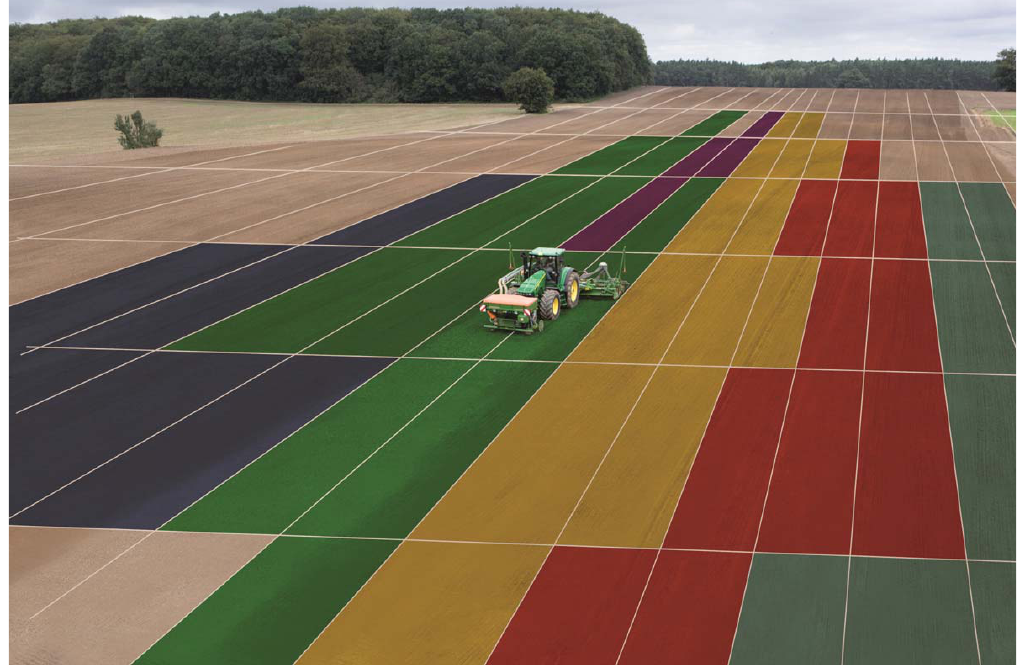
Figure 5. Precision farming through efficiently matching fertilizer application with actual soil nutrient needs. The colour indicates soil nutrient demand based on satellite and other data from field sensors and farmer knowledge (Image from John Deere/Land-Data